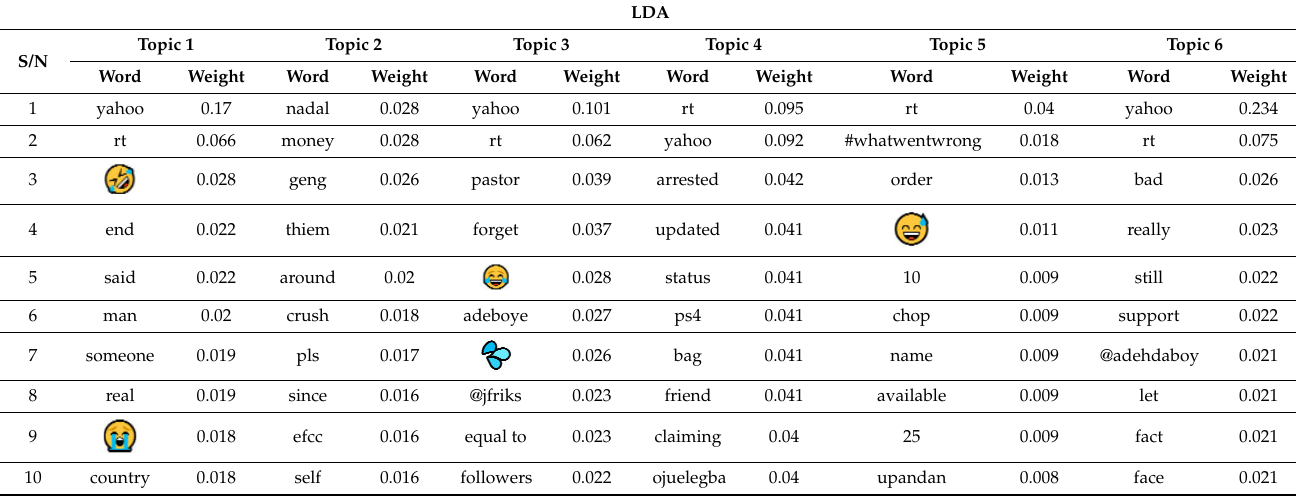
Figure 9. The cloud of words that constitutes LDA and LSI generated topics 1, 2, 3, 4, 5 and 6. Table 5. LDA selected topics with top 10 words and